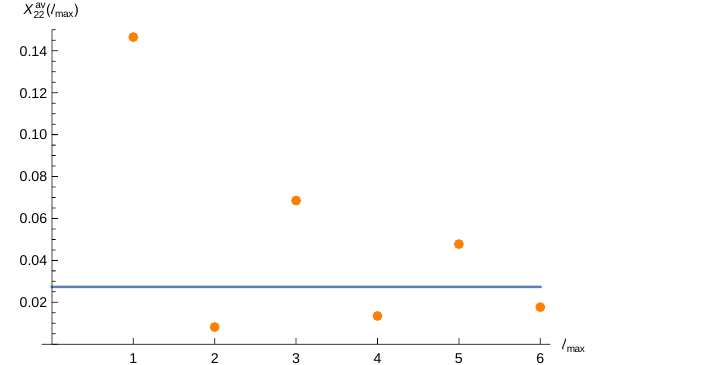
Figure 8 . Orange dots show X av horizontal line at 0 : 0274114 represents X KZ